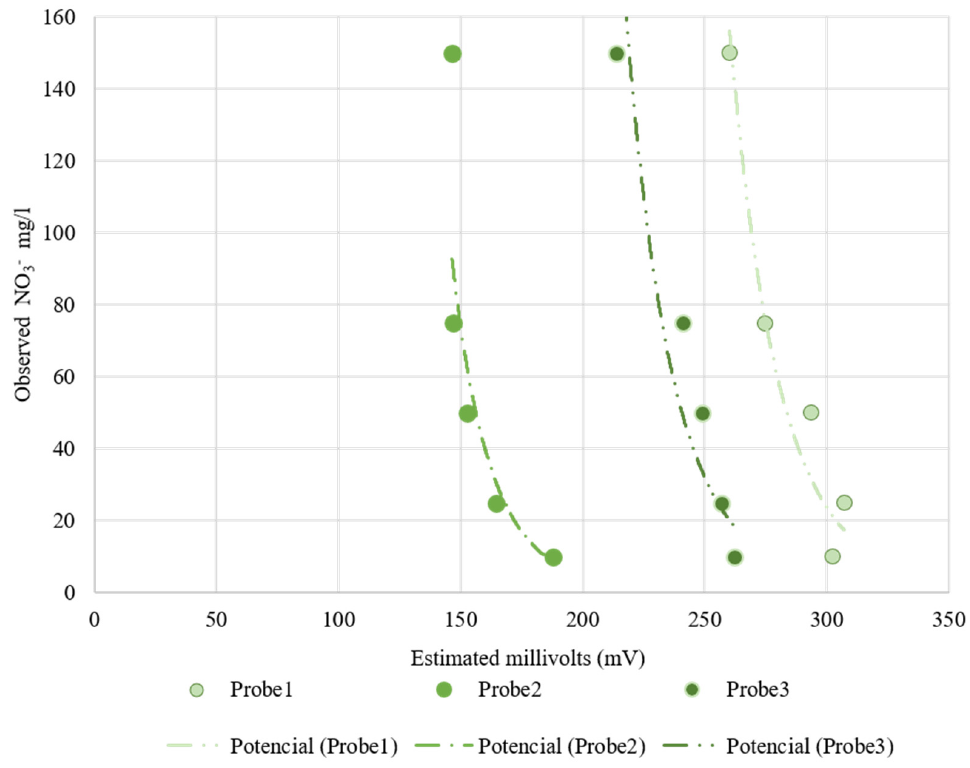
Figure 10. Nutrisens probes’ behavior at increasing nitrate concentration at a 35% volumetric soil moisture. On the x -axis is the estimated millivolts reading by the probes and on the y -axis is the observed nitrate concentration. Table 4. Fitting and determination coefficient for the Nutrisens probes when increasing the nitrate concentration in sand at 35% volumetric soil moisture.